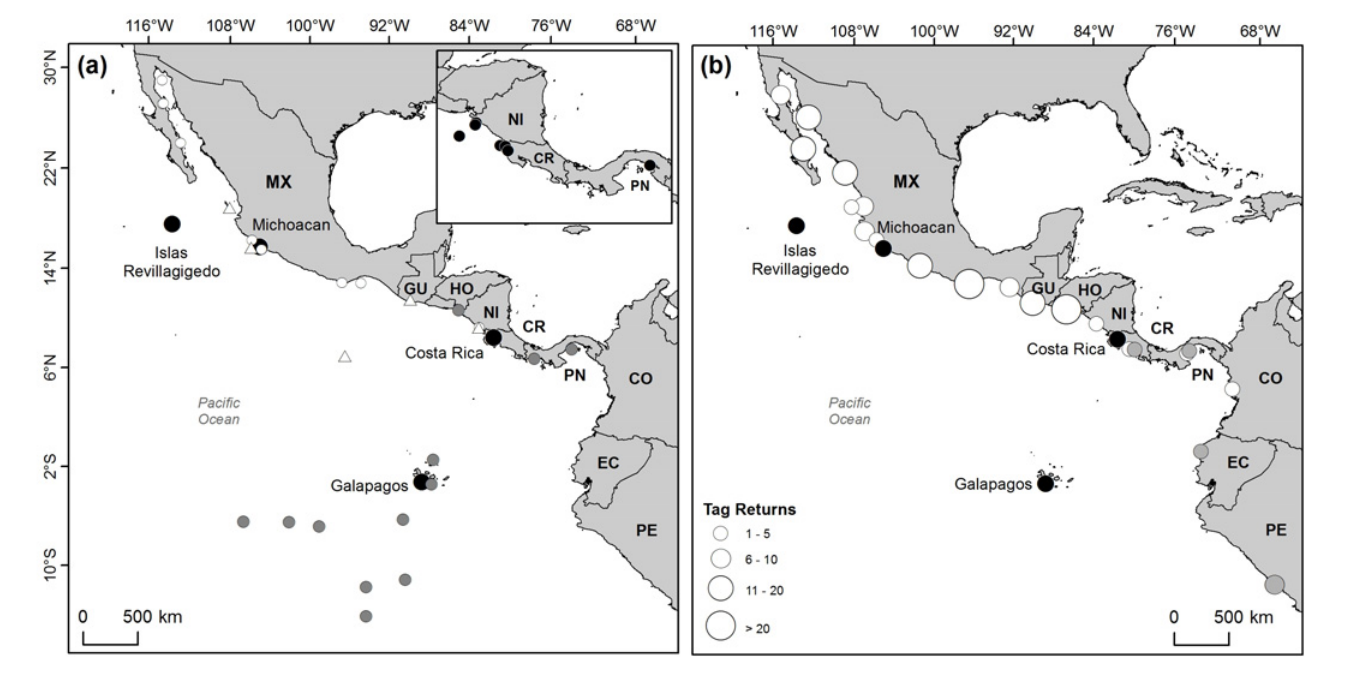
Fig 2. Distribution of adult green turtles in the Eastern Pacific Ocean. Black circles show the locations of nesting sites at the four major East Pacific green turtle rookeries: Michoacán, the Galapagos Islands, Islas Revillagigedo and the north Pacific Coast of Costa Rica. (a) Distribution of ending positions of green turtles satellite tracked from Michoacán nesting grounds: this study (white circles n = 12) and Byles et al. [71] (white triangles, n = 5,). Grey circles represent end points from turtles tracked from the Galapagos Islands (n = 12; Seminoff et al. [50]). Inset map: end positions for turtles tracked from Costa Rica and represented by grey circles (n = 9; Blanco et al. [57]). (b) Number and location of tag returns from turtles flipper tagged in Michoacán = white circles (Alvarado & Figueroa [43]; Marquez & Carrasco [45] Zavala pers comm; Llamas pers comm) and the Galapagos Islands = grey circles (Green [38]). Circles are scaled to the range of tag returns for each region. Fig. 2 (b) does not include the 44 tag returns that were reported within the state of Michoacán. MX: Mexico; GU: Guatemala; HO: Honduras; NI: Nicaragua; CR: Costa Rica; PN: Panama; COL: Columbia; EC: Ecuador; PE: